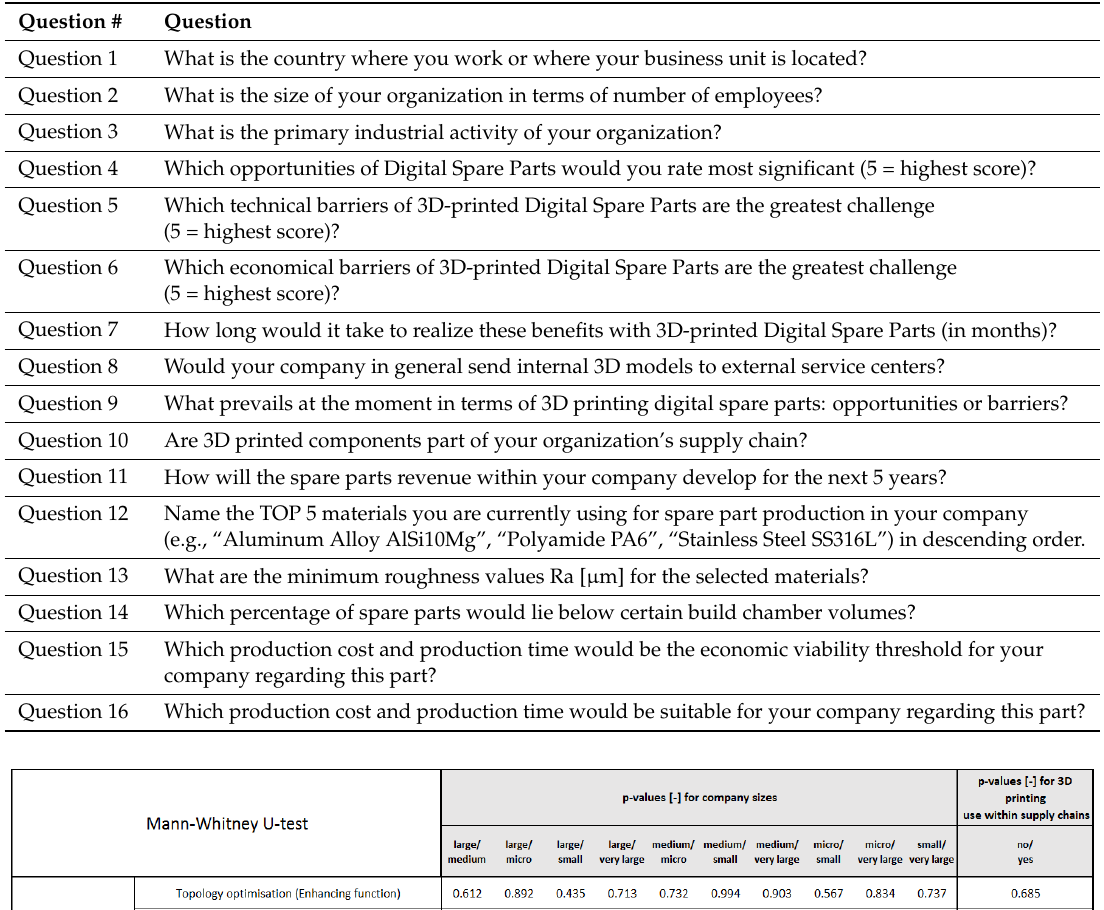
Table A1. List of survey questions.